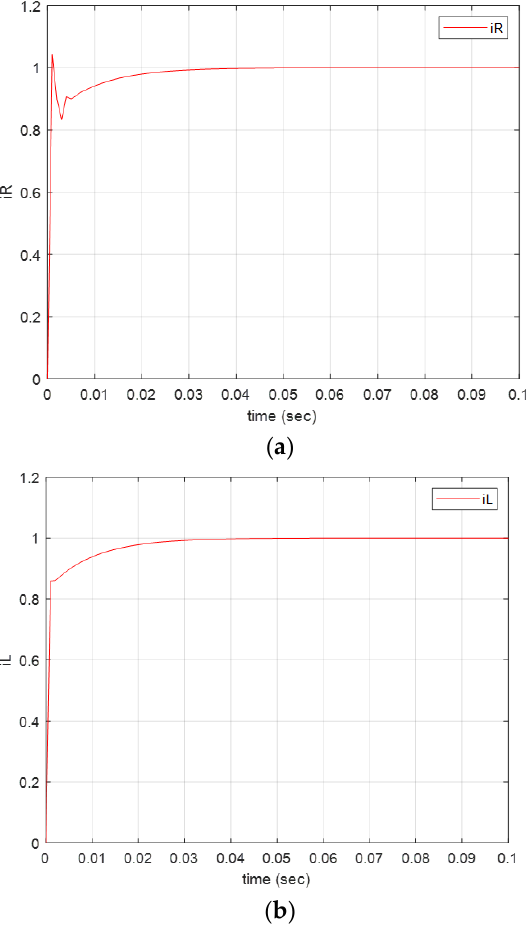
Figure 9. The step response using the designed PI controller: ( a ) load current, ( b ) inductor current.